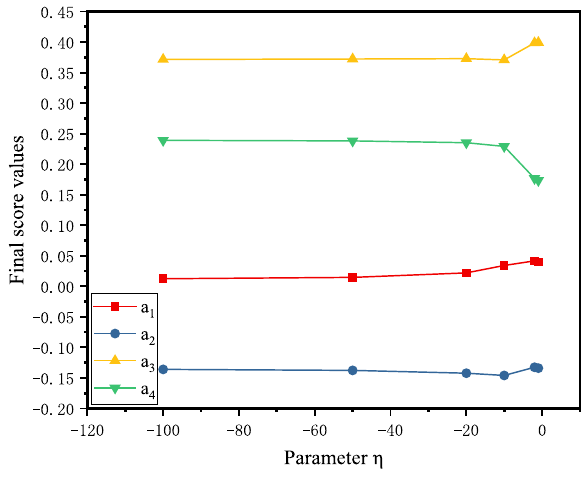
Fig. 7 Score values of the alternative using the improved Borda rule for different η